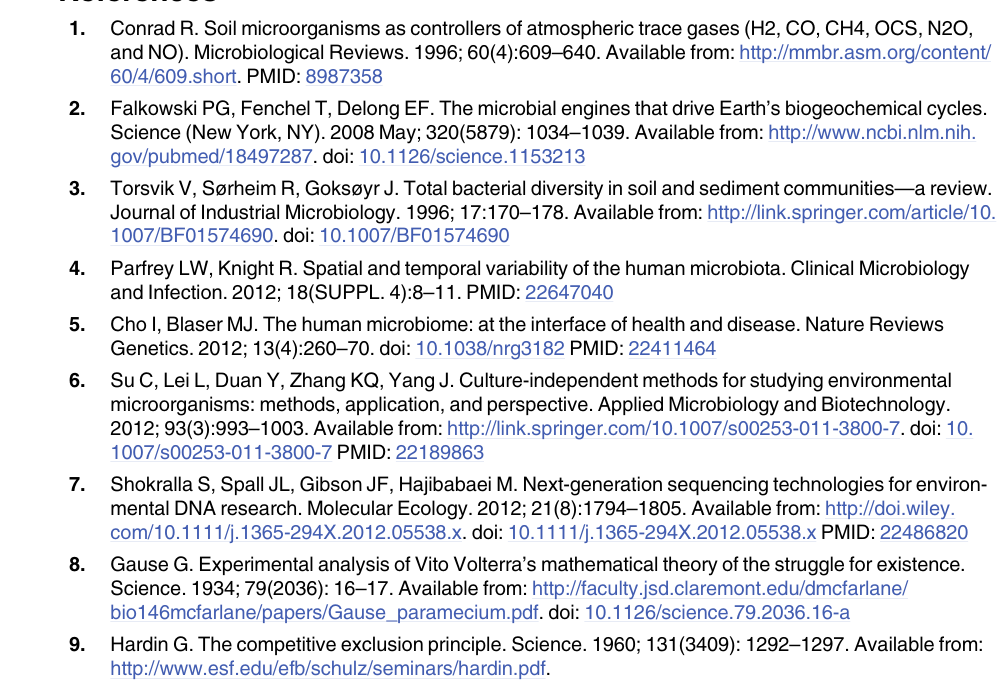
(TIF) S5 Fig. Population dynamics in environments with amino acid supplementation. Repeated simulations (n = 100) are plotted for varying benefit-to-cost ratios (BCR) and degrees of amino acid diffusion (bold line: mean, shaded ribbon: standard deviation). All simulations start with a random distribution of all genotypes and undergo a specific dynamic alternation of genotypes frequencies. Depending on the genotype ’ s strategy, it can repress, facilitate, or even outcompete others (see text for more details). Legend: red = wild type, blue = overproducing genotype, yellow = auxotroph (2 types), green = cross-feeder (2 types). (TIF) S1 Text. Laboratory experiments.